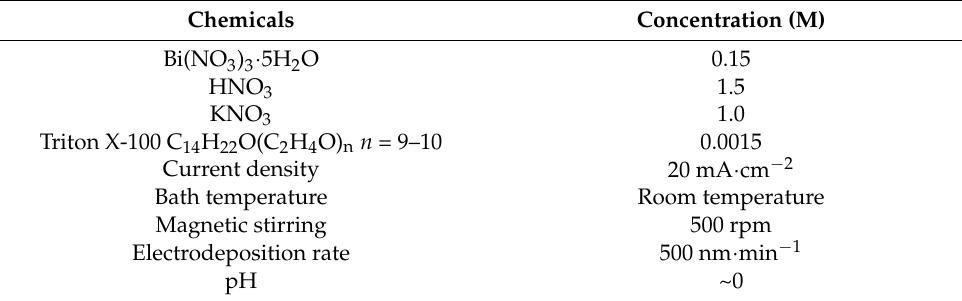
Table 1. Bath composition and plating conditions for thin Bi film